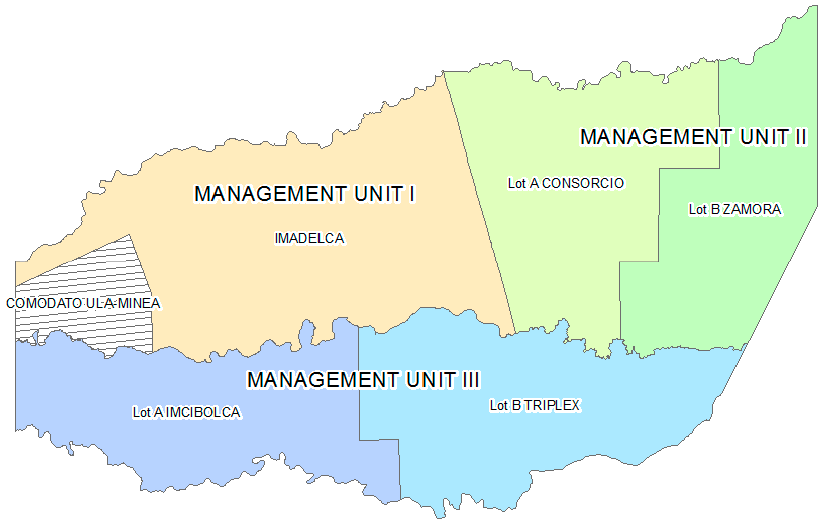
Figure A2. Administrative management units listing the concessions allocated in the CFR.